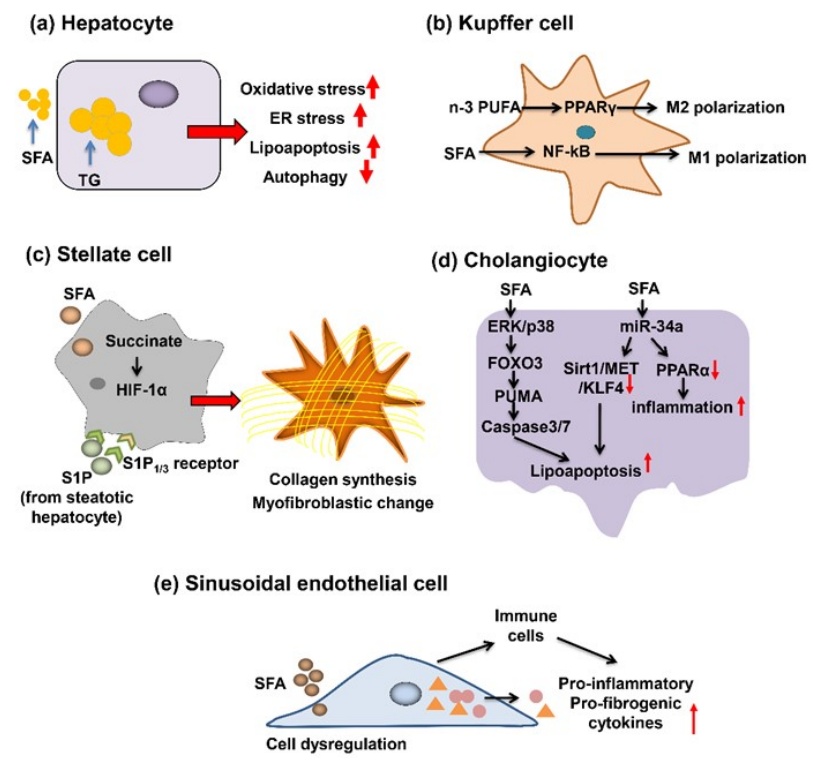
Figure 2. Impacts of dietary SFA on various cells in the liver. ( a ) In hepatocytes, SFA promotes fibrogenesis by enhanced oxidative/ER stress, lipoapoptosis and attenuated autophagy. ( b ) In Kupffer cells, n-3 PUFA polarizes to M2 in PPAR γ -dependent manner, while SFA activates NF- κ B to induce the pro-inflammatory M1 phenotype. ( c ) In hepatic stellate cells, palmitate and succinate can stimulate S1P/S1P receptors and HIF-1 α axes and promotes myofibroblastic change. ( d ) In cholangiocytes, SFA promotes lipoapoptosis and inflammation. ( e ) In hepatic sinusoidal endothelial cells, SFA triggers dysregulation and changes into the pro-inflammatory and pro-fibrogenic phenotypes, partially through interaction with immune cells. Arrows: ↑ , Increased; ↓ , Decreased.